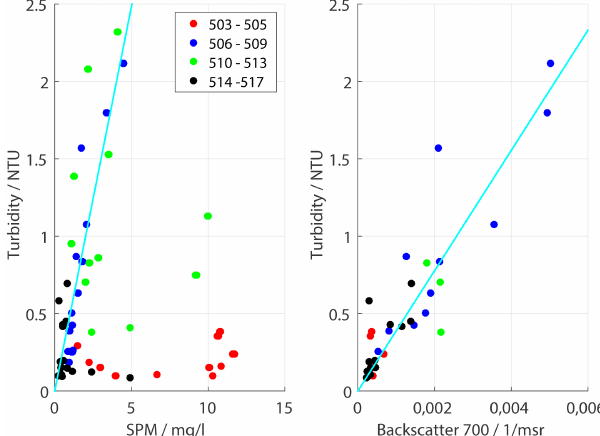
Figure 5. Comparison between Chl a concentrations and chloro- phyll fluorescence for the CTD casts. The cyan line represents Eq. (6). Red and blue dots represent stations in Uummannaq Fjord; green dots are stations in Vaigat and black dots are stations in Disko Bay.